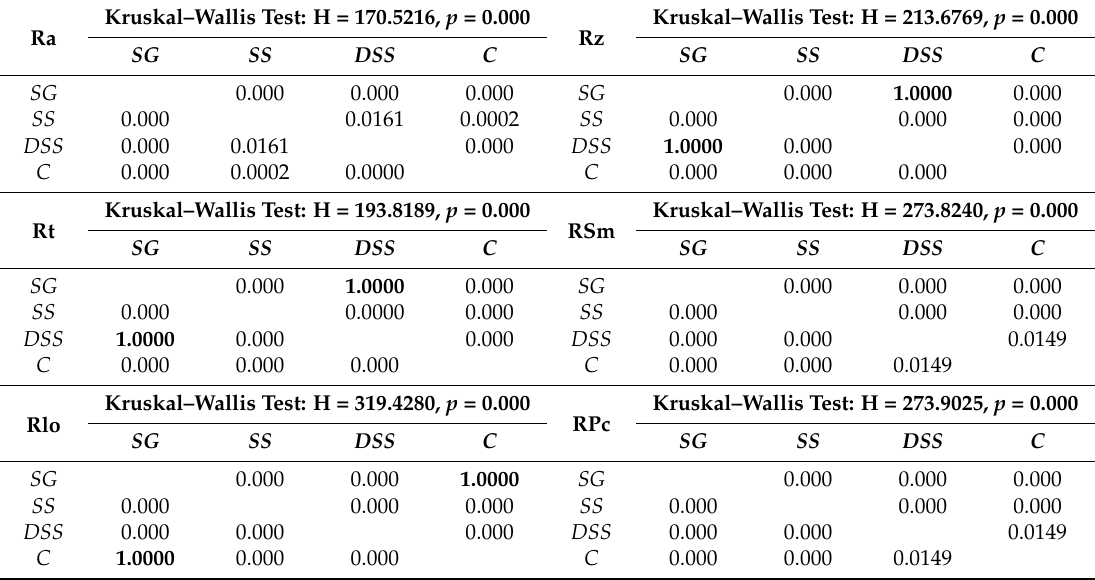
Table 10. Kruskal–Wallis test of the blasting